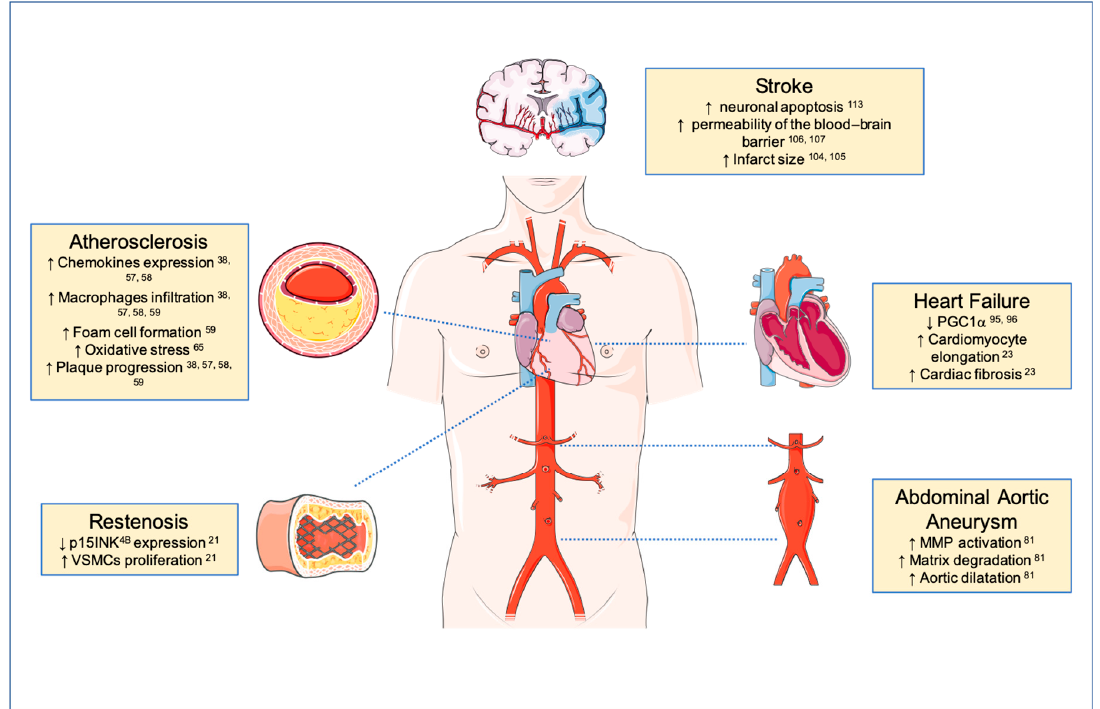
Figure 2 . TWEAK/Fn14 axis in cardiovascular disease. Schematic representation of TWEAK roles in pathological cardiovascular remodeling diseases. TWEAK in cardiovascular diseases (CVDs) affect inflammatory cells, cardiomyocytes, fibroblasts, endothelial and smooth muscle cells (SMCs) in CVDs. TWEAK/Fn14 axis interaction promotes pathological tissue remodeling; atherosclerosis (inflammation, lipid accumulation and plaque progression, and instability), restenosis (SMCs proliferation, migration, and cyclins regulation), heart failure (cardiomyocytes dysfunction and fibrosis), abdominal aortic aneurysm (inflammation, matrix degradation, AAA progression, angiogenesis).